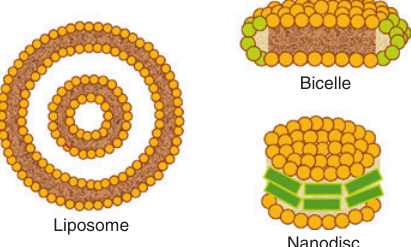
Figure 6: Schematic representation of liposomes, bicelles and nanodiscs used as membrane mimetics in study of membrane proteins structure and function. The liposome shown here has two lipid bilayers. Generally, the mutilamellar liposomes consist of several bilayers, whereas the unilamellar liposomes have only one bilayer. Bicelles have discoidal shape and are formed by mixing lipids with long (orange) and short (green) chains. Nanodiscs are discoidal lipid nanoobjects, which integrity and shape are supported by a belt of two scaffold proteins illustrated in obtained for a typical sample is contributed by two factors: (1) the intramolecular signal of interest, which